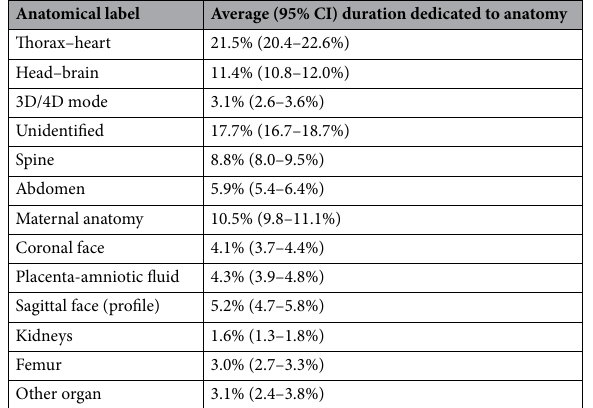
Table 2. Proportion of scan duration dedicated toward each of the 12 most common anatomical labels in 341 full-length second-trimester anomaly scans. Data is percent (95% confidence interval).